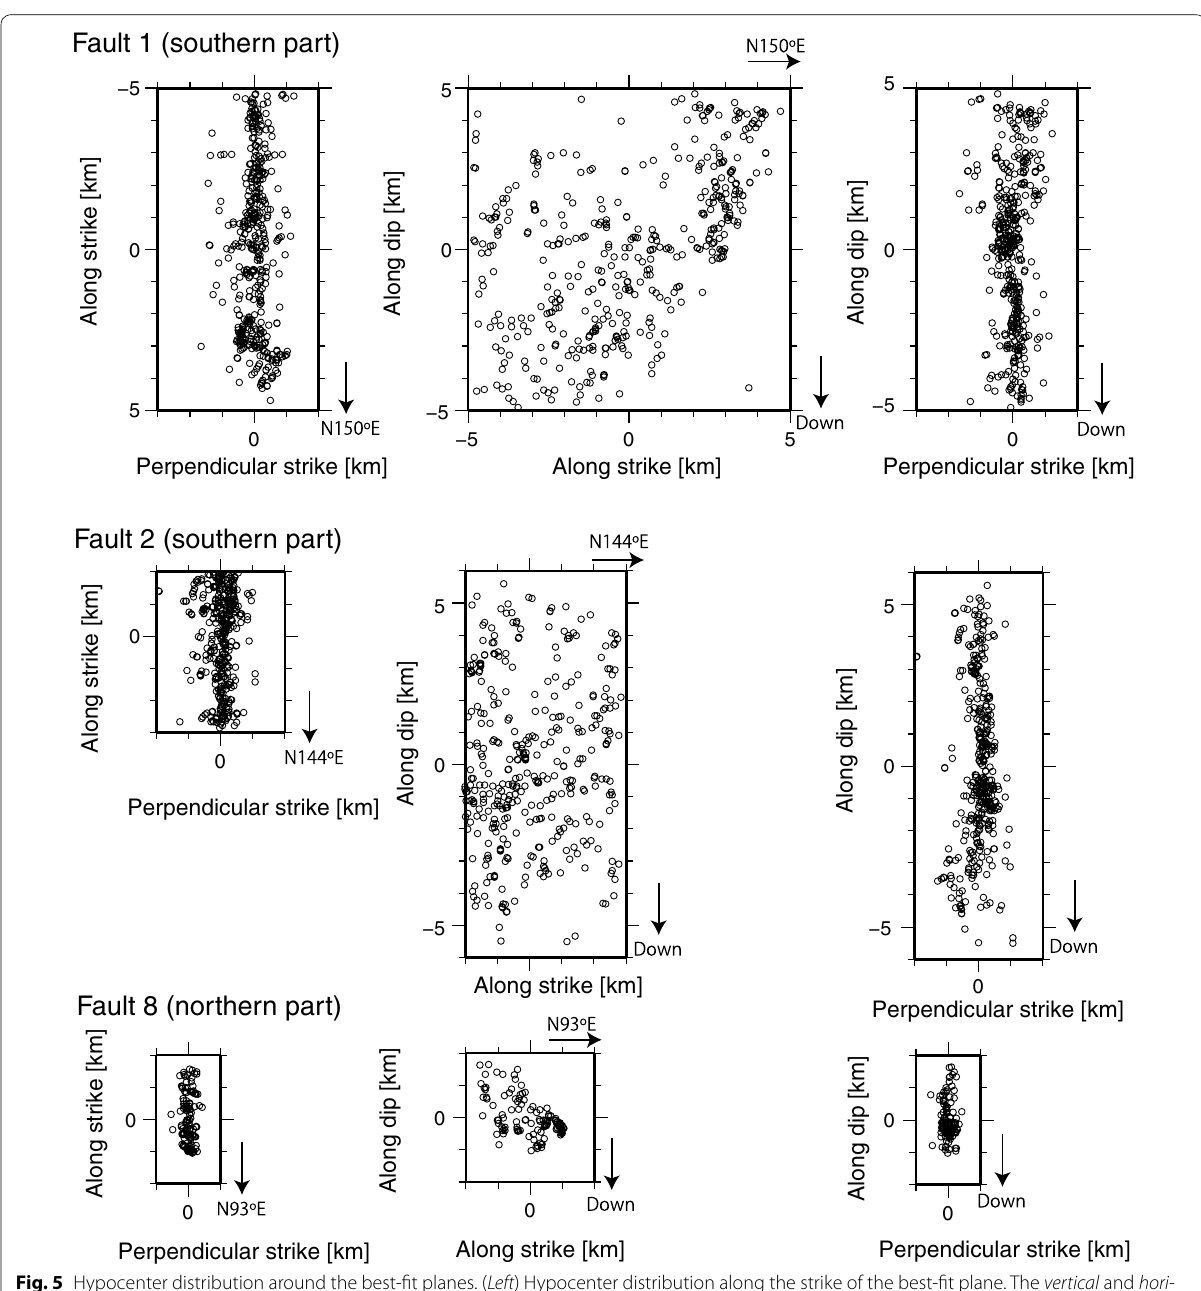
Fig. 5 Hypocenter distribution around the best-fit planes. ( Left ) Hypocenter distribution along the strike of the best-fit plane. The vertical and hori- zontal axes indicate, respectively, the directions along and normal to the best-fit plane. ( Middle ) and ( right ) Hypocenter distributions projected onto and perpendicular to the best-fit fault plane, respectively. ( Top ) Hypocenter distribution around Fault 1 ( middle ) that around Fault 2 and ( bottom ) that around Fault 8 in Fig.